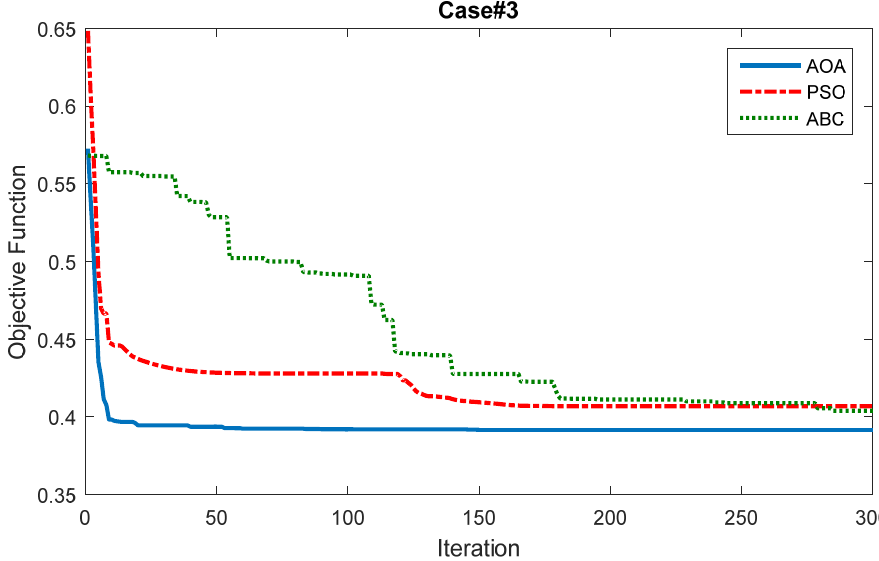
Figure 15. Convergence curve of different optimization methods in solving the OSPF.